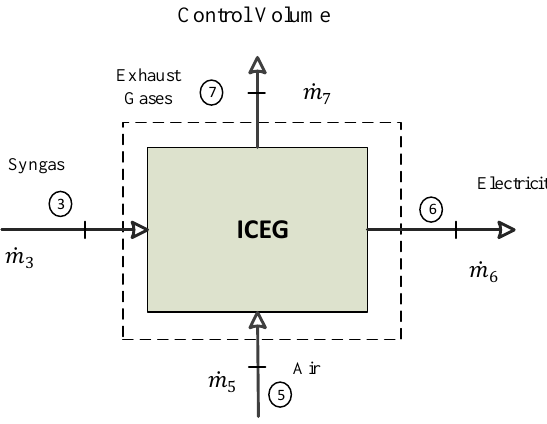
Figure 2. Control volume of the power generation system.